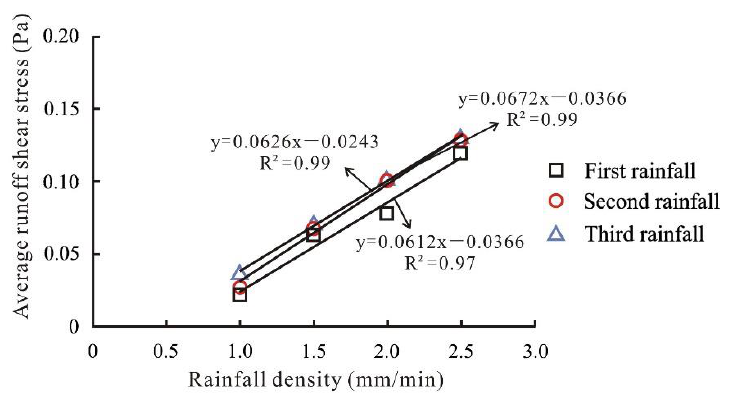
Figure 21. Linear fitting relationship between average runoff power and rainfall density of the sand- covered